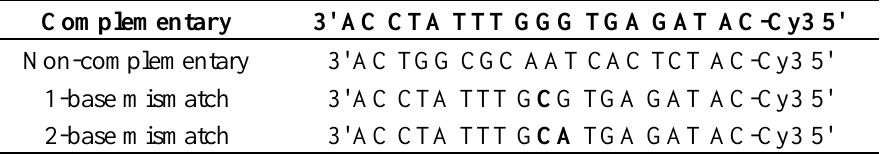
Table 1. Sequences of the different types of DNA